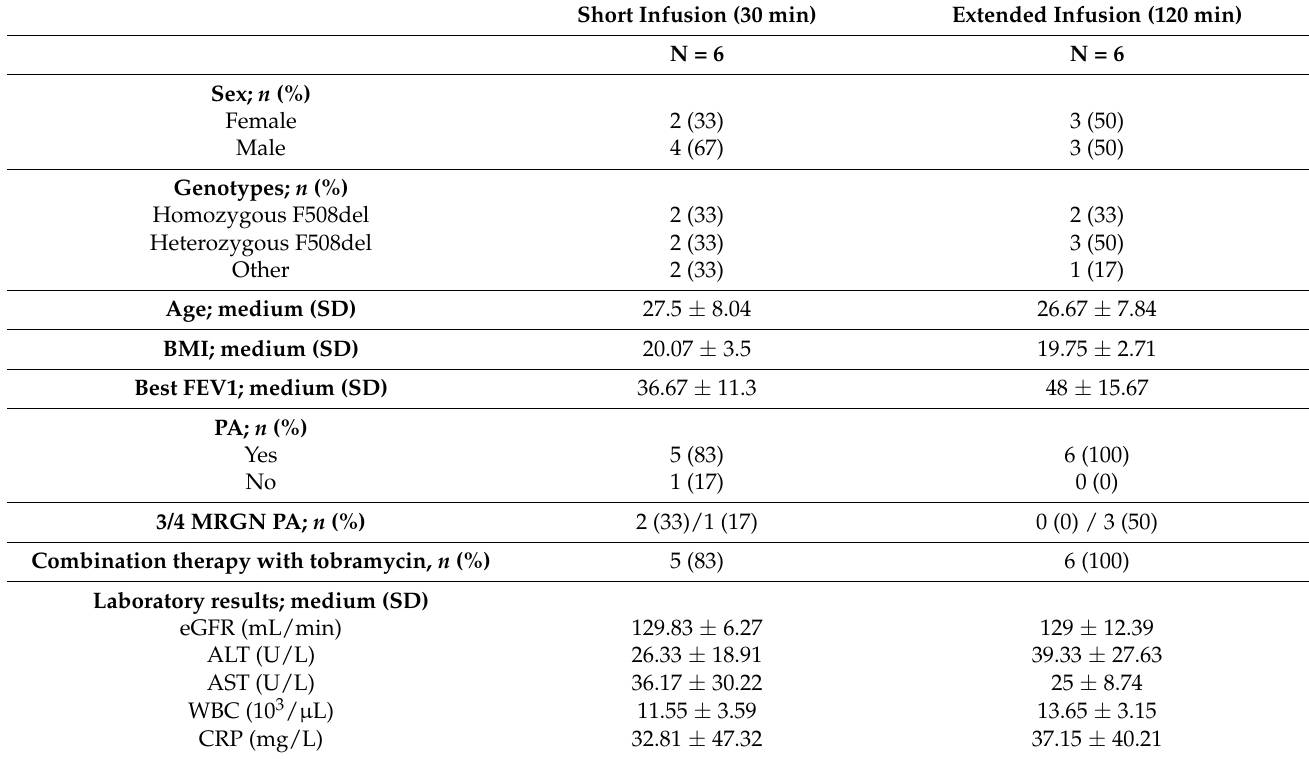
Table 1. Key characteristics of people with cystic fibrosis (CF) in the two treatment groups. Short Infusion (30 min) Extended Infusion (120 min) N = 6 N =